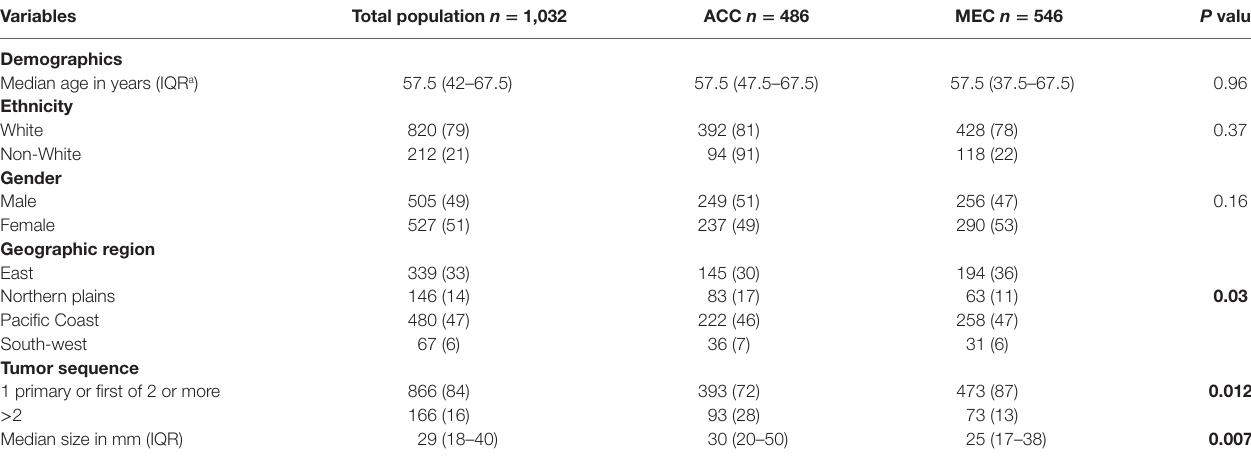
TaBle 1 | Characteristics of the study population with diagnosis of primary pulmonary adenoid cystic carcinoma (ACC) and mucoepidermoid carcinoma